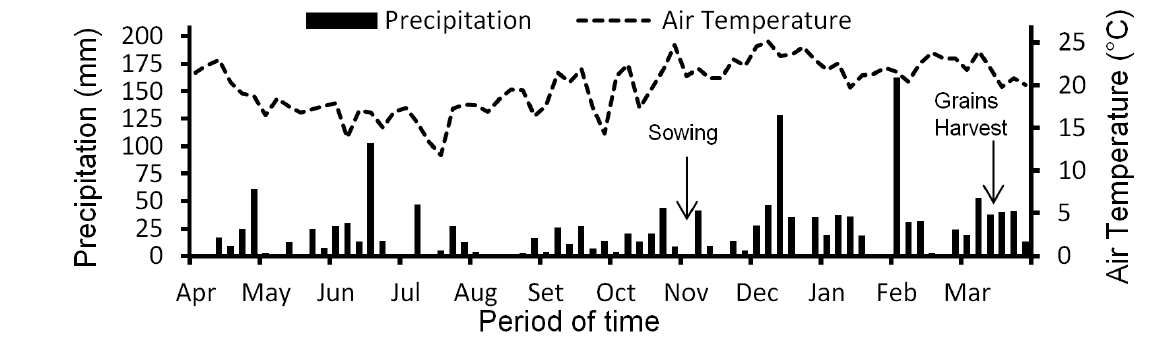
Figure 1 - Air temperature and precipitation during the research period from April to